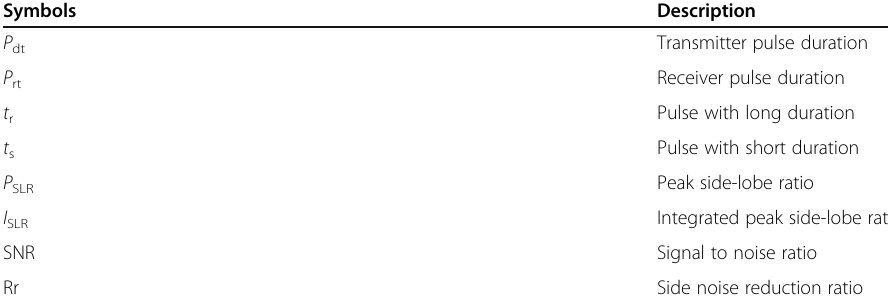
Table 1 Abbreviations